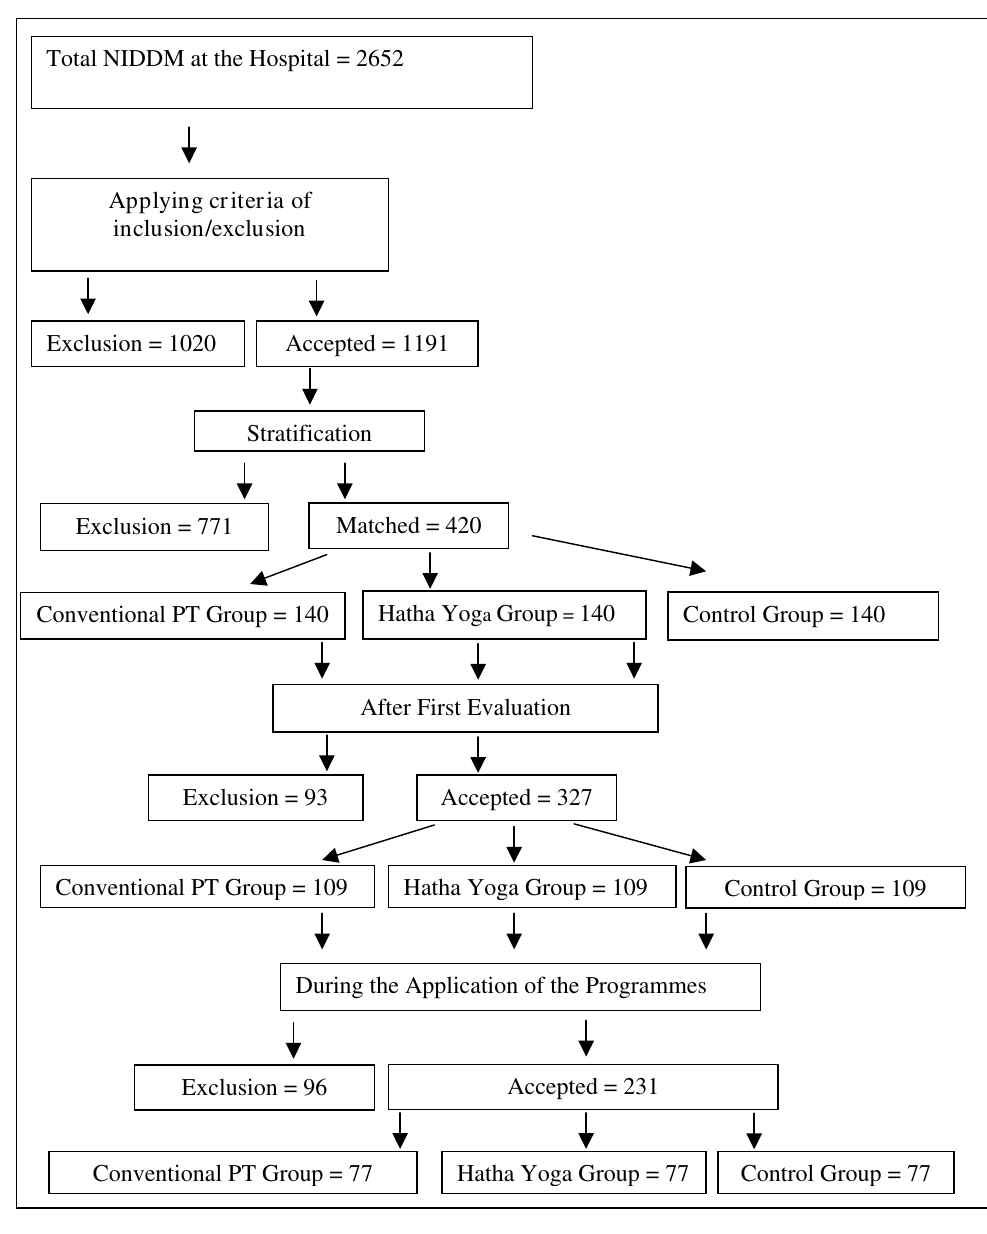
Schematic diagram representing the study design